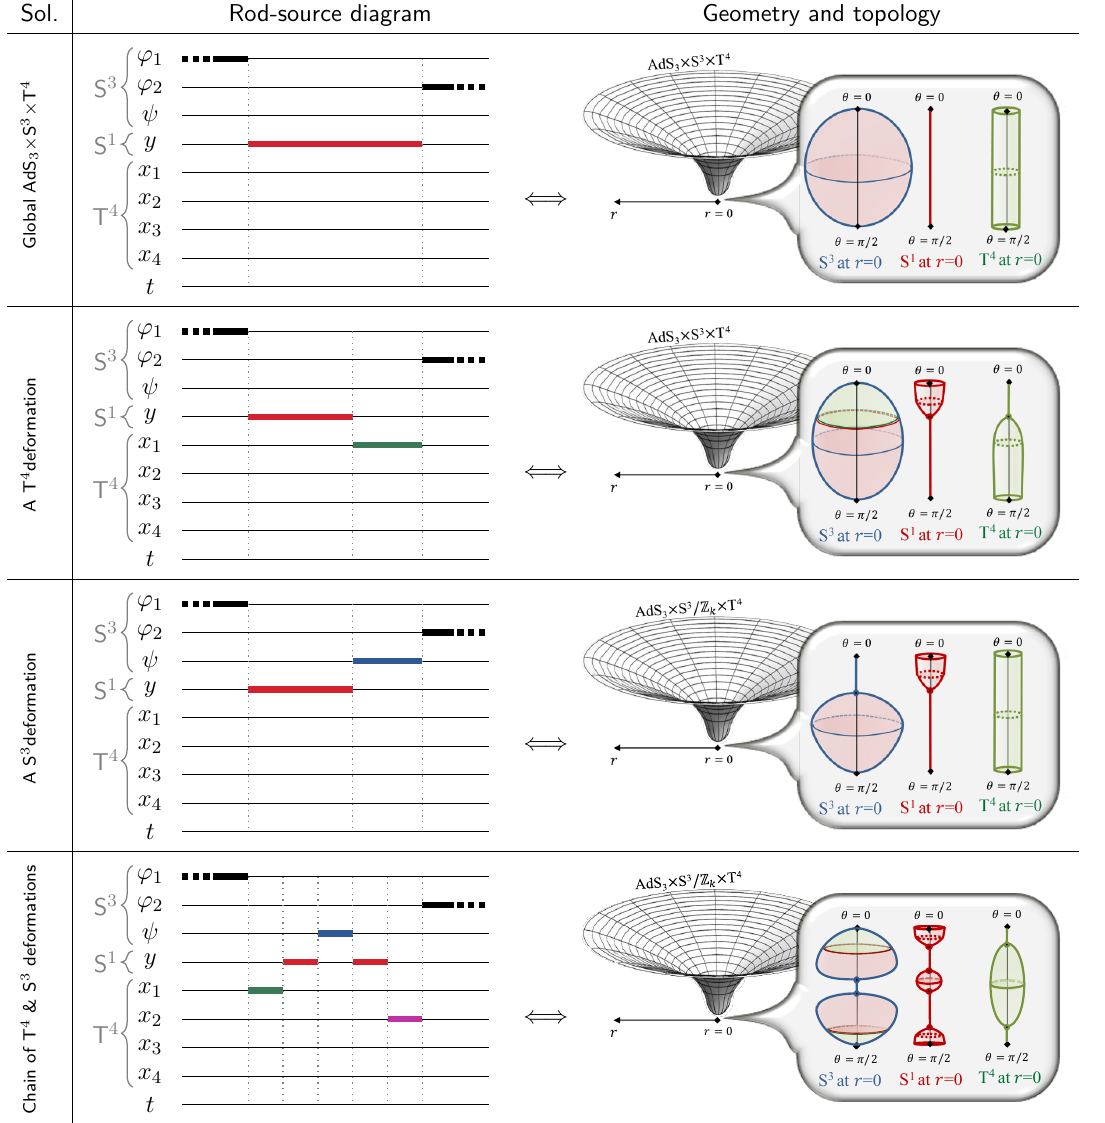
Table 1 . Description of the static axially-symmetric smooth solutions constructed in this paper that are asymptotic to AdS S 3 × T 4 in type IIB with a potential orbifold on the S 3 . The left-hand 3 × sides depict the rod sources that force a direction to degenerate on the symmetry axis. The S 1 ( y ) is the internal circle of the AdS region, ϕ and ϕ are spherical angles of the S 3 while ψ is its Hopf 3 1 2 fibration angle, and the T 4 is parametrized by x . The right-hand sides show the geometries as a a function of r and θ giving the position on the AdS and S 3 respectively. We depicted the topology 3 of the S 3 , S 1 , and T 4 at the end-to-spacetime locus, r = 0 , where the S 3 splits into different regions corresponding to the locus of each rod